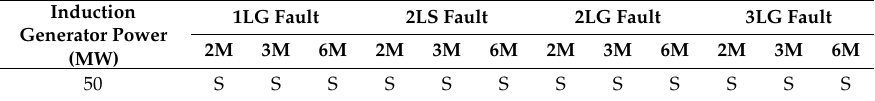
Table 2. Results of the transient stability of two-mass, three-mass and six-mass models (considering all types of damping) [52].